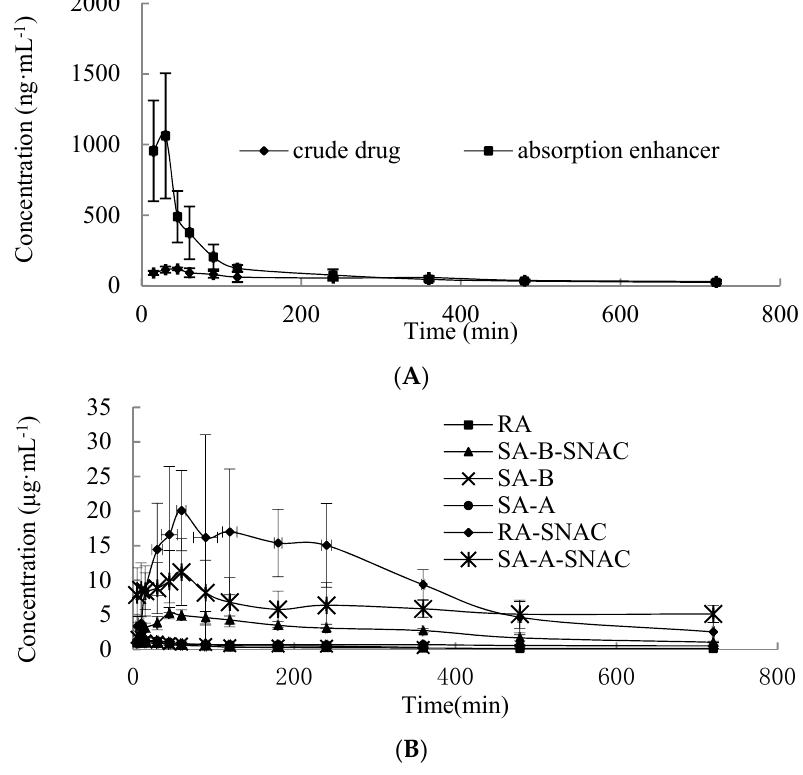
Figure 6. The concentration-time curve of drugs in blood after oral administration of notoginsenoside R1 ( A ) and salvianolic acids ( B ). Values were represented as mean ± SD ( n = 6, each group).